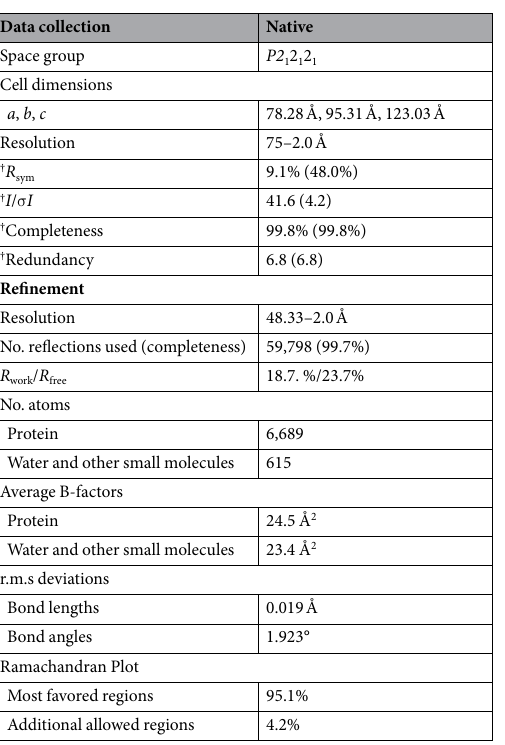
Table 1. Crystallographic statistics. † The highest resolution shells are shown in